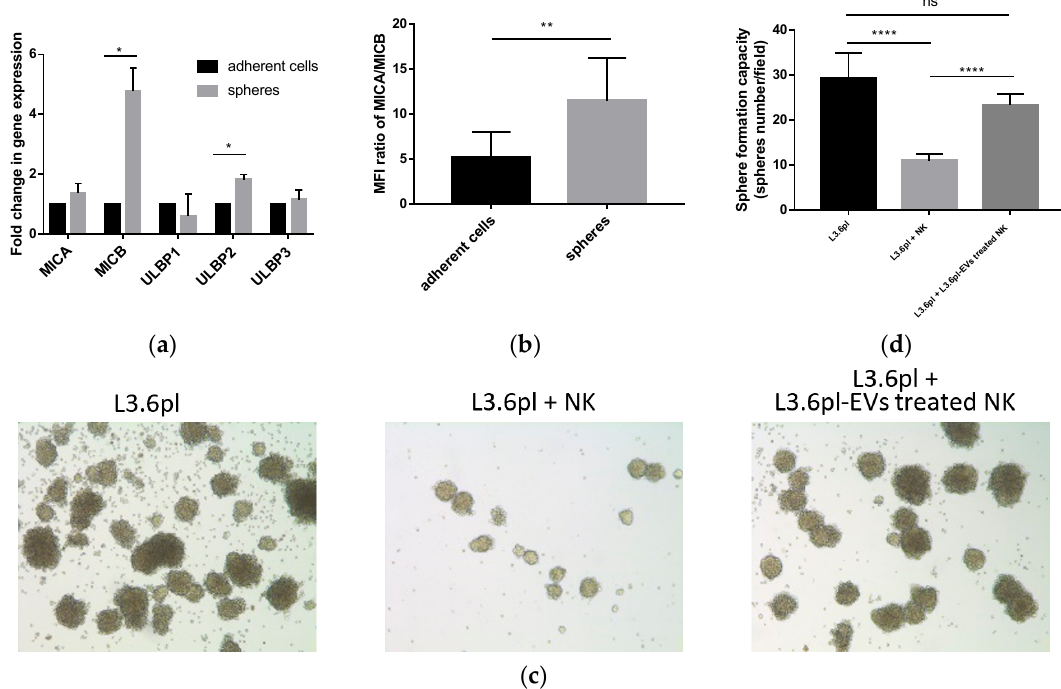
Figure 5. Pancreatic cancer-derived EVs suppress NK cell cytotoxicity against cancer stem cells (CSCs). ( a ) Gene expression of NKG2D ligands in adherent cells and spheres using qRT-PCR. Data were normalized to GAPDH and presented as fold change in comparison with genes in adherent cells. ( b ) The MFI of MICA/MICB in adherent cells and spheres was determined by flow cytometry. ( c ) Representative images of tumor spheres without NK cell killing (left), tumor spheres after untreated NK cell killing (middle), and tumor spheres after L3.6pl-derived EVs pre-treated NK cell killing (right). ( d ) The number of tumor spheres without NK cell killing, tumor spheres after untreated NK cell killing, and tumor spheres after L3.6pl-derived EV-pre-treated NK cell killing. Data are the means ± SD of four experiments. ns, no significant difference, * p < 0.05, ** p < 0.01, *** p < 0.001, **** p < 0.0001 by Student’s t test.